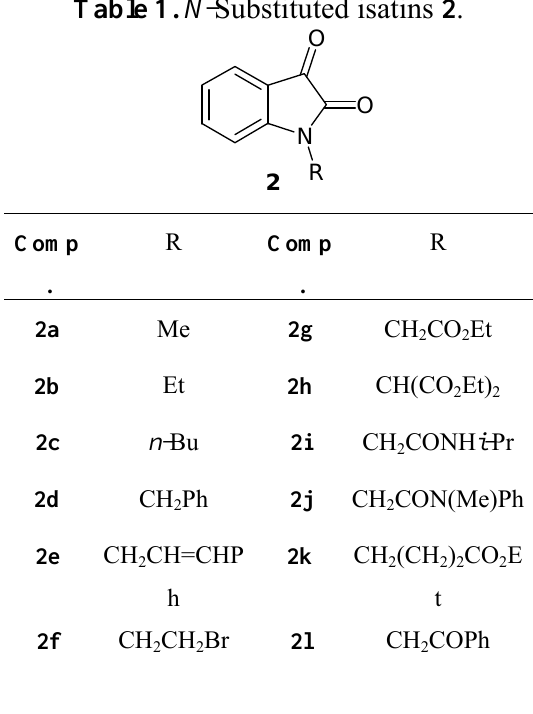
Table 1. N- Substituted isatins 2